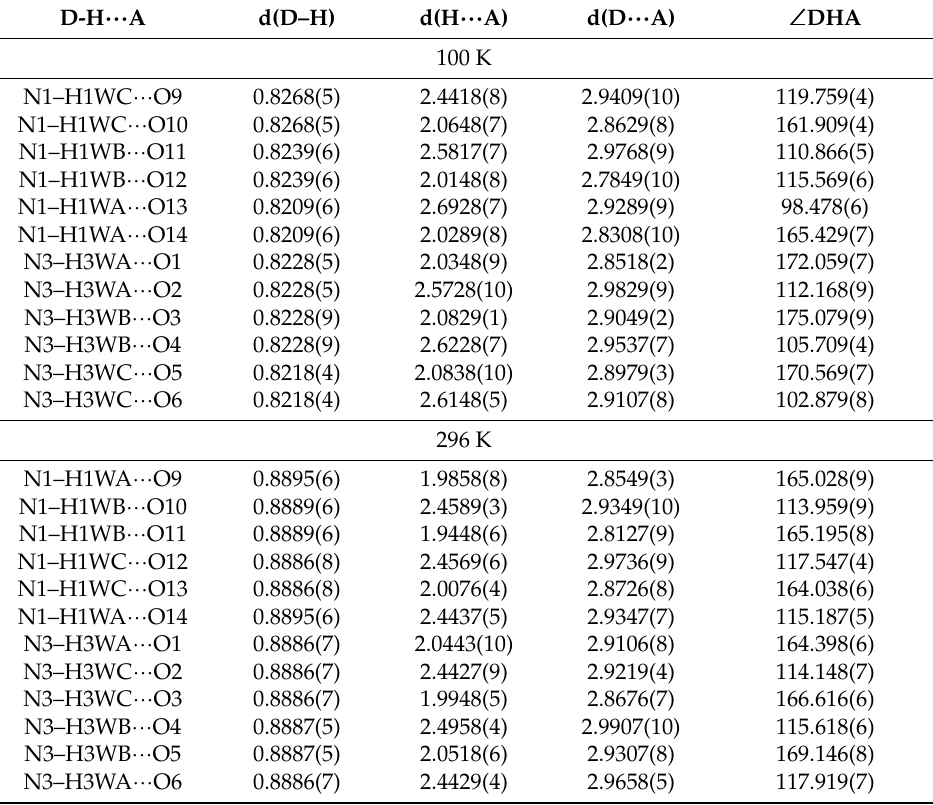
Table 2. Hydrogen bond N–H ··· O geometry (Å, ◦ ) for complex 1